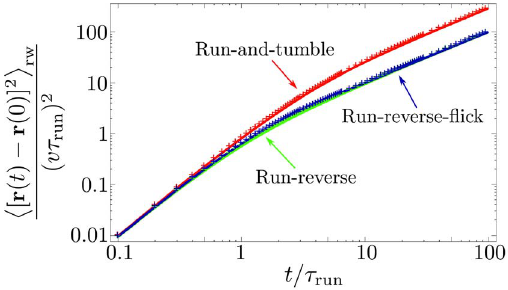
Figure 4. Mean squared displacement (MSD). The curves of the normalized MSD versus dimensionless time t = t run correspond to E. coli ’s run-and-tumble with a ~ 0 : 33 (red), run-reverse with a ~{ 1 (green), and run-reverse-flick with alternating a ~{ 1 and a ~ 0 (blue). The analytical expressions are given in Eqs. (13) and (22), respectively. The crosses are obtained from numerical simulations and fully agree with the analytical results.